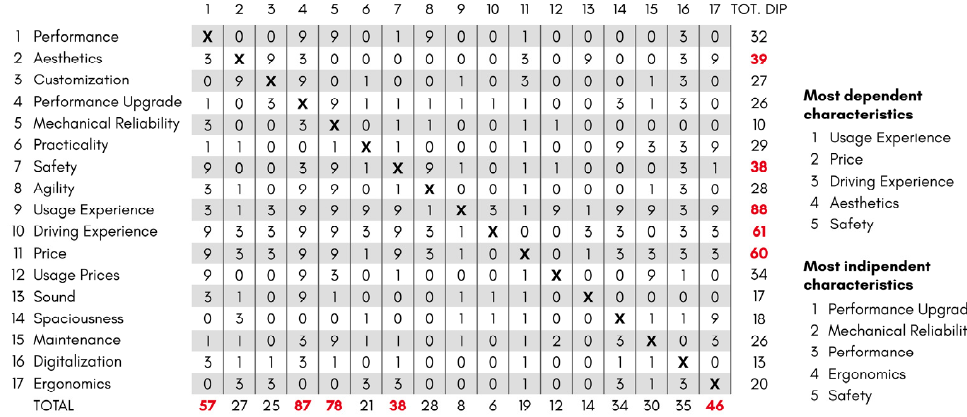
Figure 8. Matrix of dependence/independence.